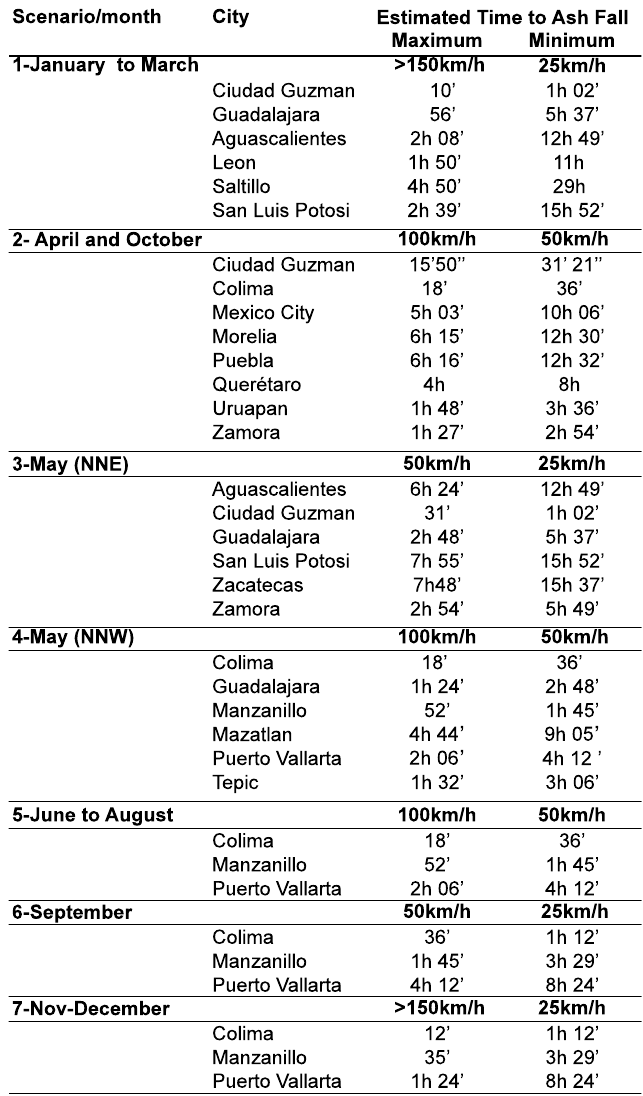
! Table 12. Estimated arrival times for ash in the main cities, according to month of eruption and maximum and minimum wind